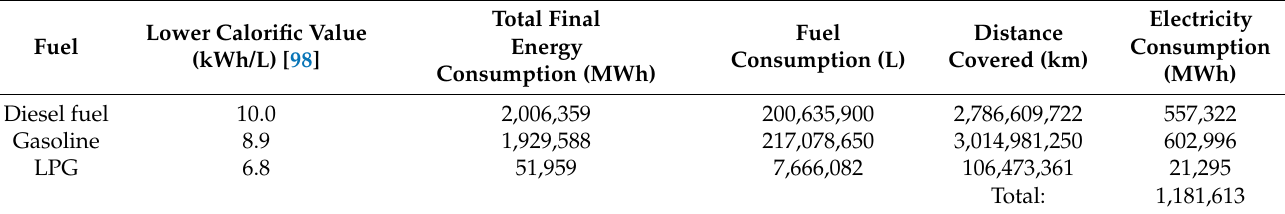
Table 8. Estimation of the expected annual electricity consumption in Crete for